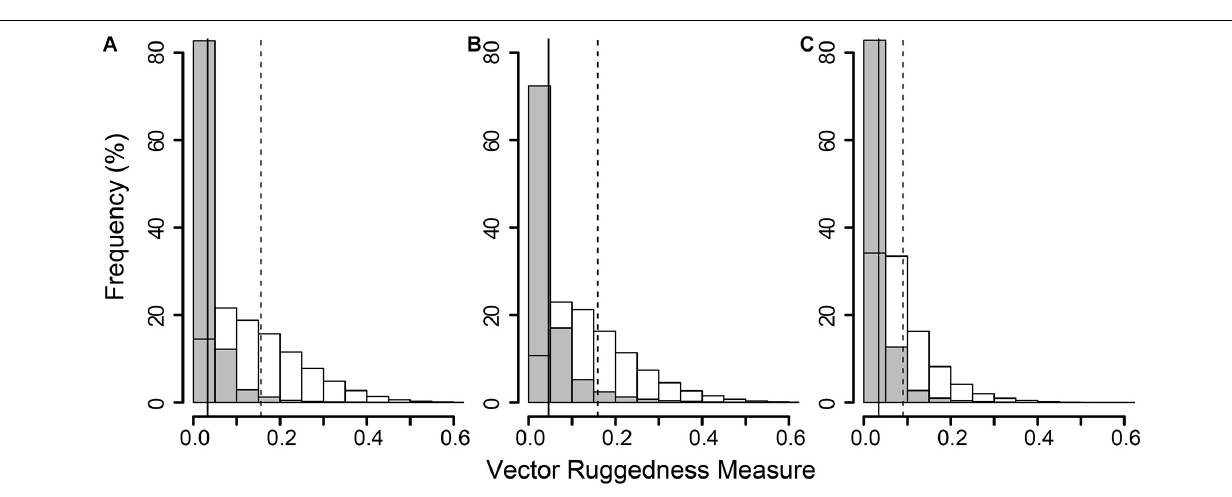
M. oculata displayed clustered patterns up to ∼ 0.5 and 0.6